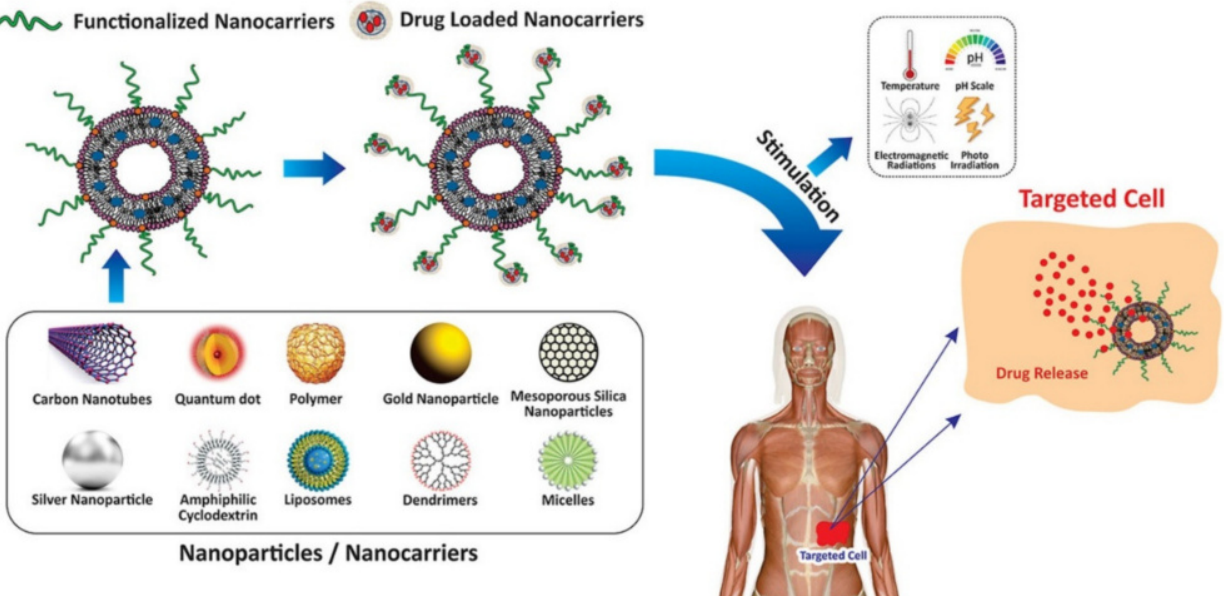
Figure 1. Representation of different nanoparticles reaching targeted sites. Reprinted from Journal of Drug Delivery Science and Technology, Vol 62, Afzal Shah, Saima Aftab, Jan Nisar, Muhammad Naeem Ashiq, Faoza Jan Iftikhar, Nanocarriers for targeted drug delivery, vol. 62, 102426, Copyright (2022), with permission from Elsevier. Reprinted from the Lancet, vol. 62, Afzal Shah, Saima Aftab, Jan Nisar, Muhammad Naeem Ashiq, Faoza Jan Iftikhar, Nanocarriers for targeted drug delivery, 102426, Copyright (2022), with permission from Elsevier